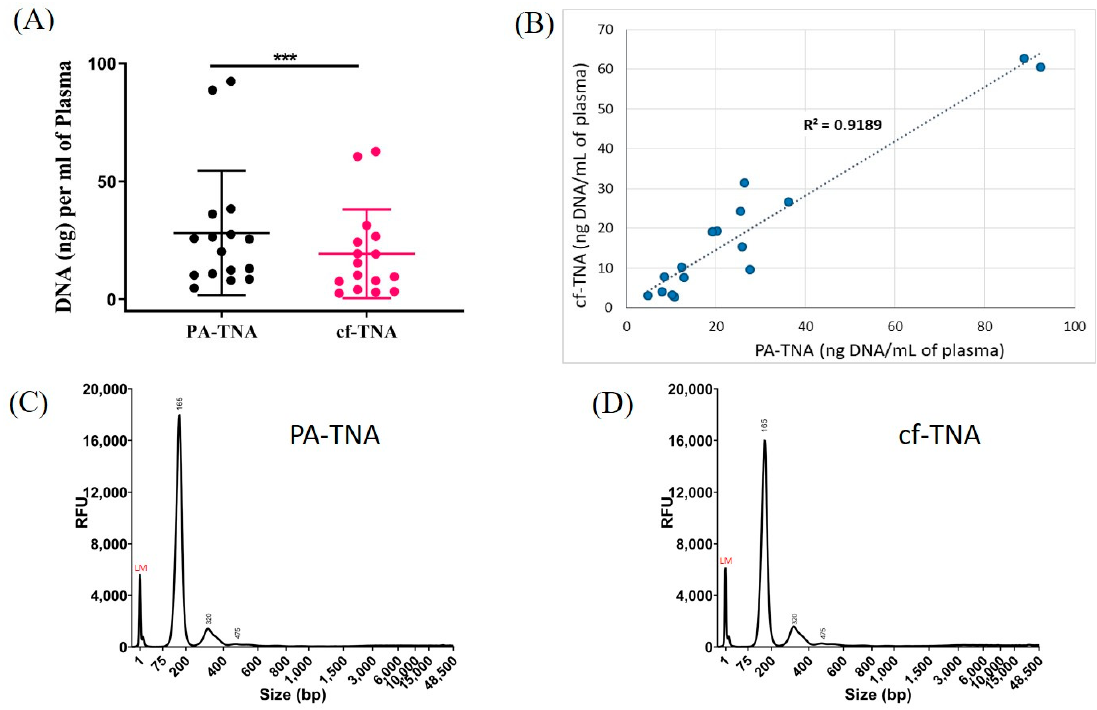
Figure 2. Peptide affinity precipitation improves recovery of nucleic acids compared to cell-free method. Total nucleic acid (TNA) was either extracted directly (cf-TNA) from non-pre-cleared EDTA plasma from sixteen NSCLC donors or from PA-precipitated material (PA-TNA) from an equivalent volume of plasma. TNA was isolated using the MagMax Cell-Free Total Nucleic Isolation Kit and DNA was quantified using the High Sensitivity DNA assay on a Qubit fluorometer. ( A ) The recovery of DNA per mL of plasma and ( B ) the correlation between DNA recovery in PA-TNA or cf-TNA isolation methods is shown ( n = 16; *** p < 0.001). A comparison of the DNA profiles obtained from assaying PA-TNA ( C ) and cf-TNA ( D ) on a Fragment Analyzer are shown (LM = lower marker).